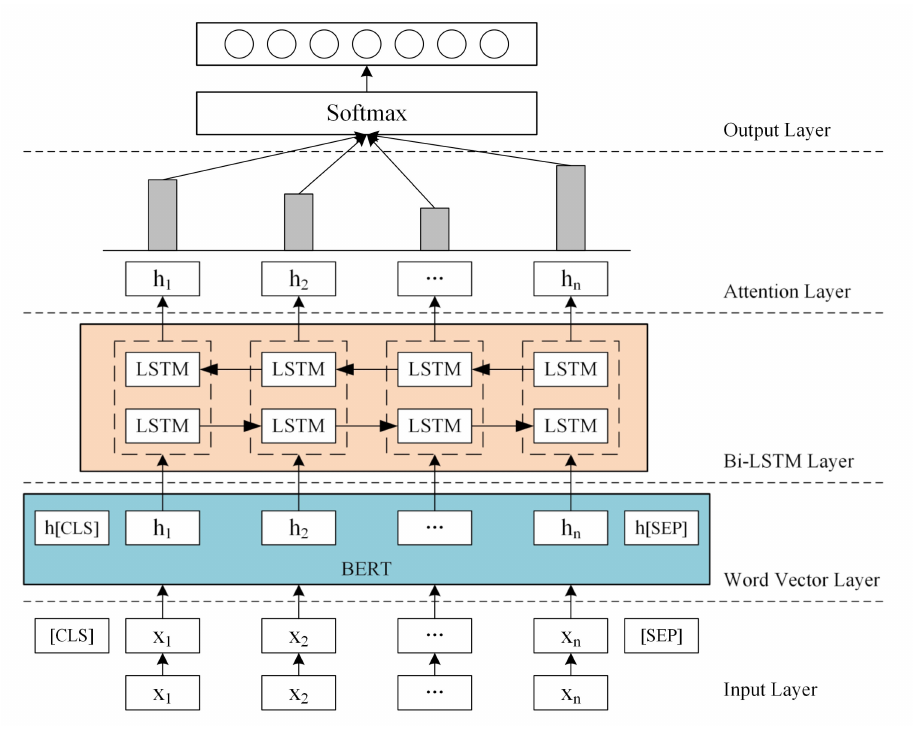
Figure 4. Emotion classification based on